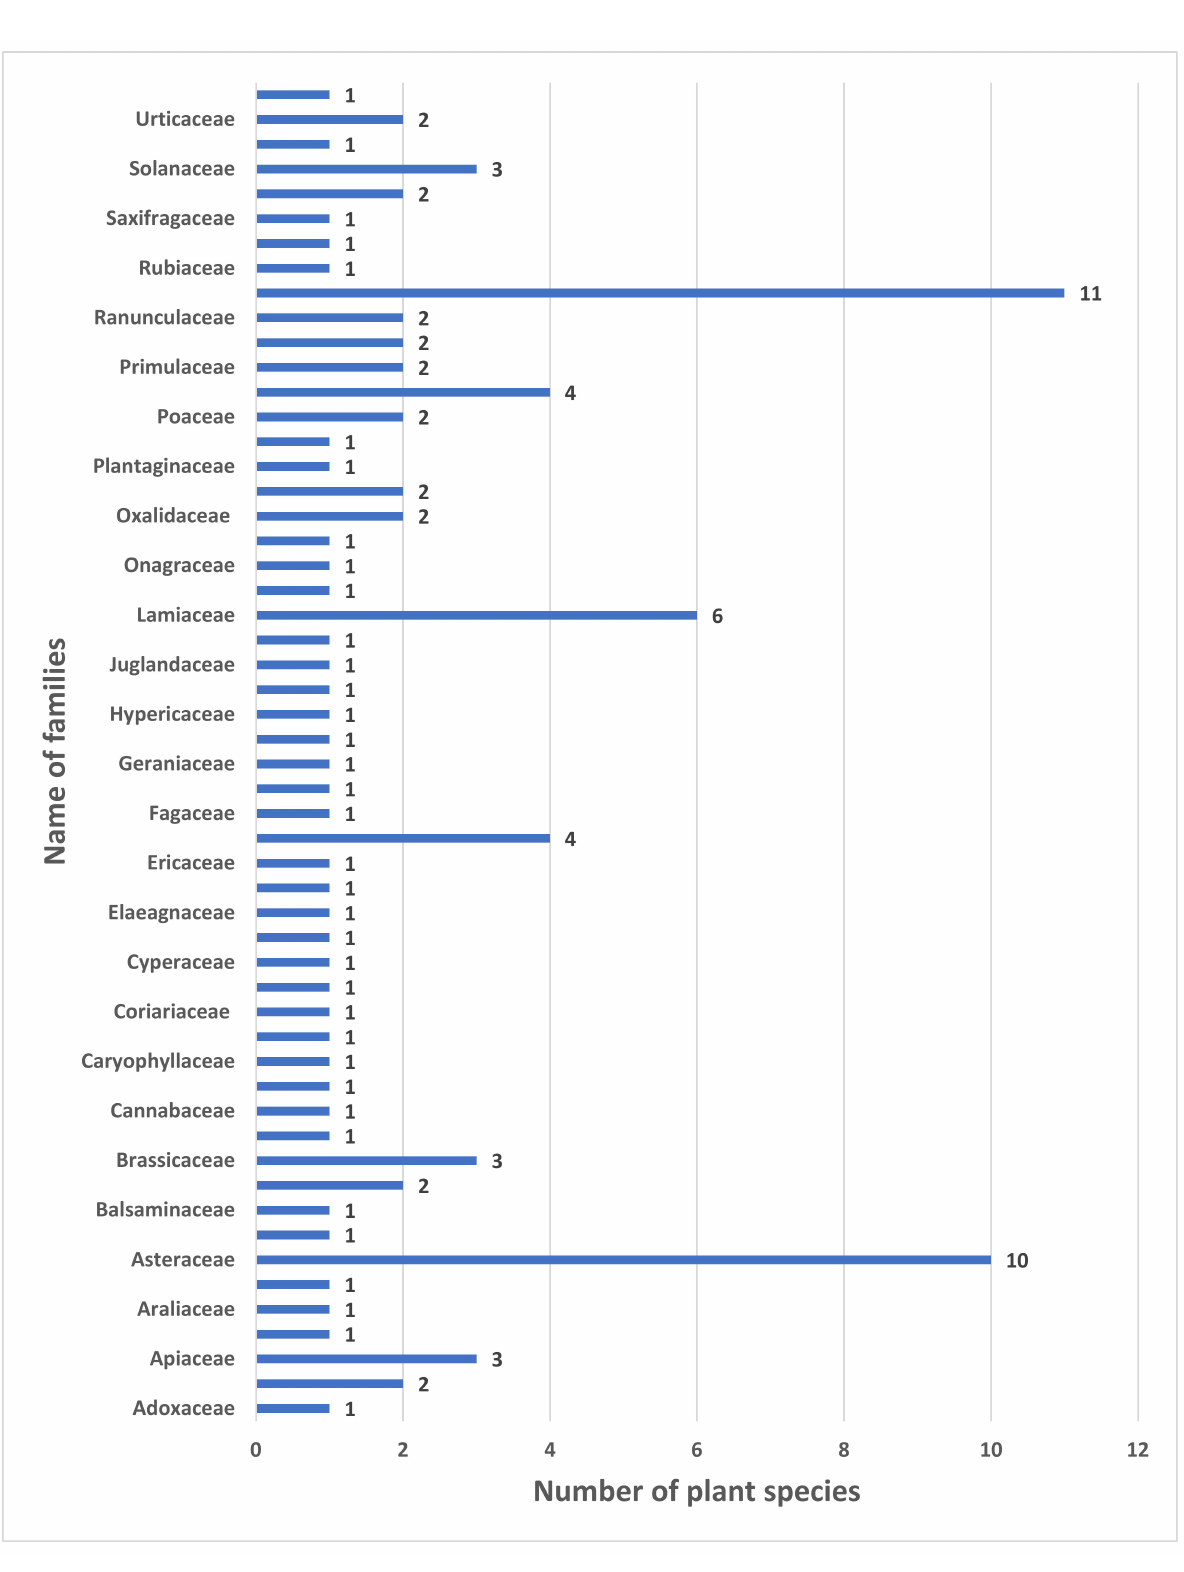
Figure 2. Representation of the families and number of plants studied at study